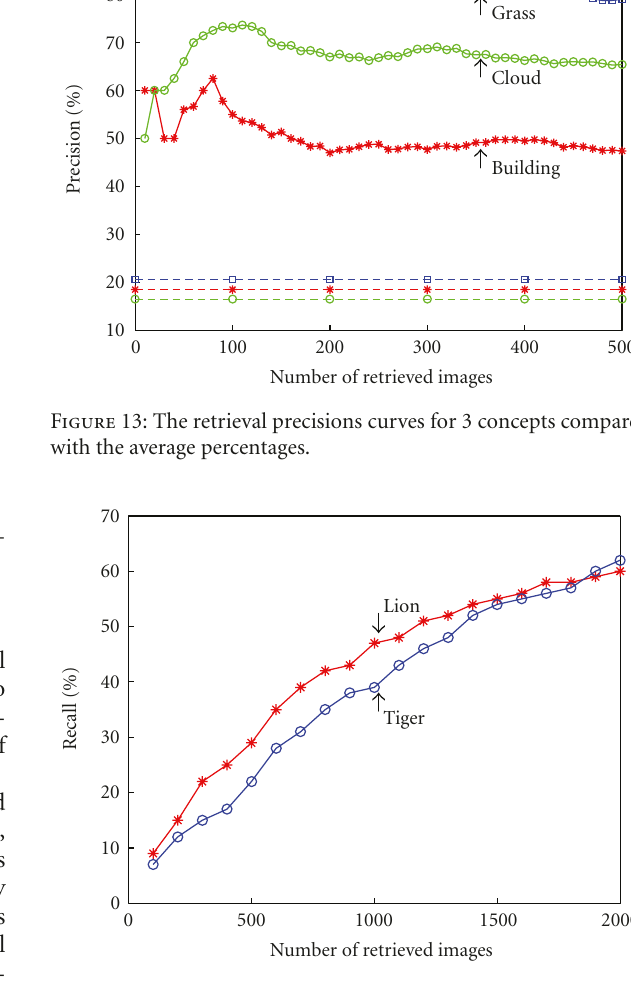
Figure 14: The retrieval recall curves of 2